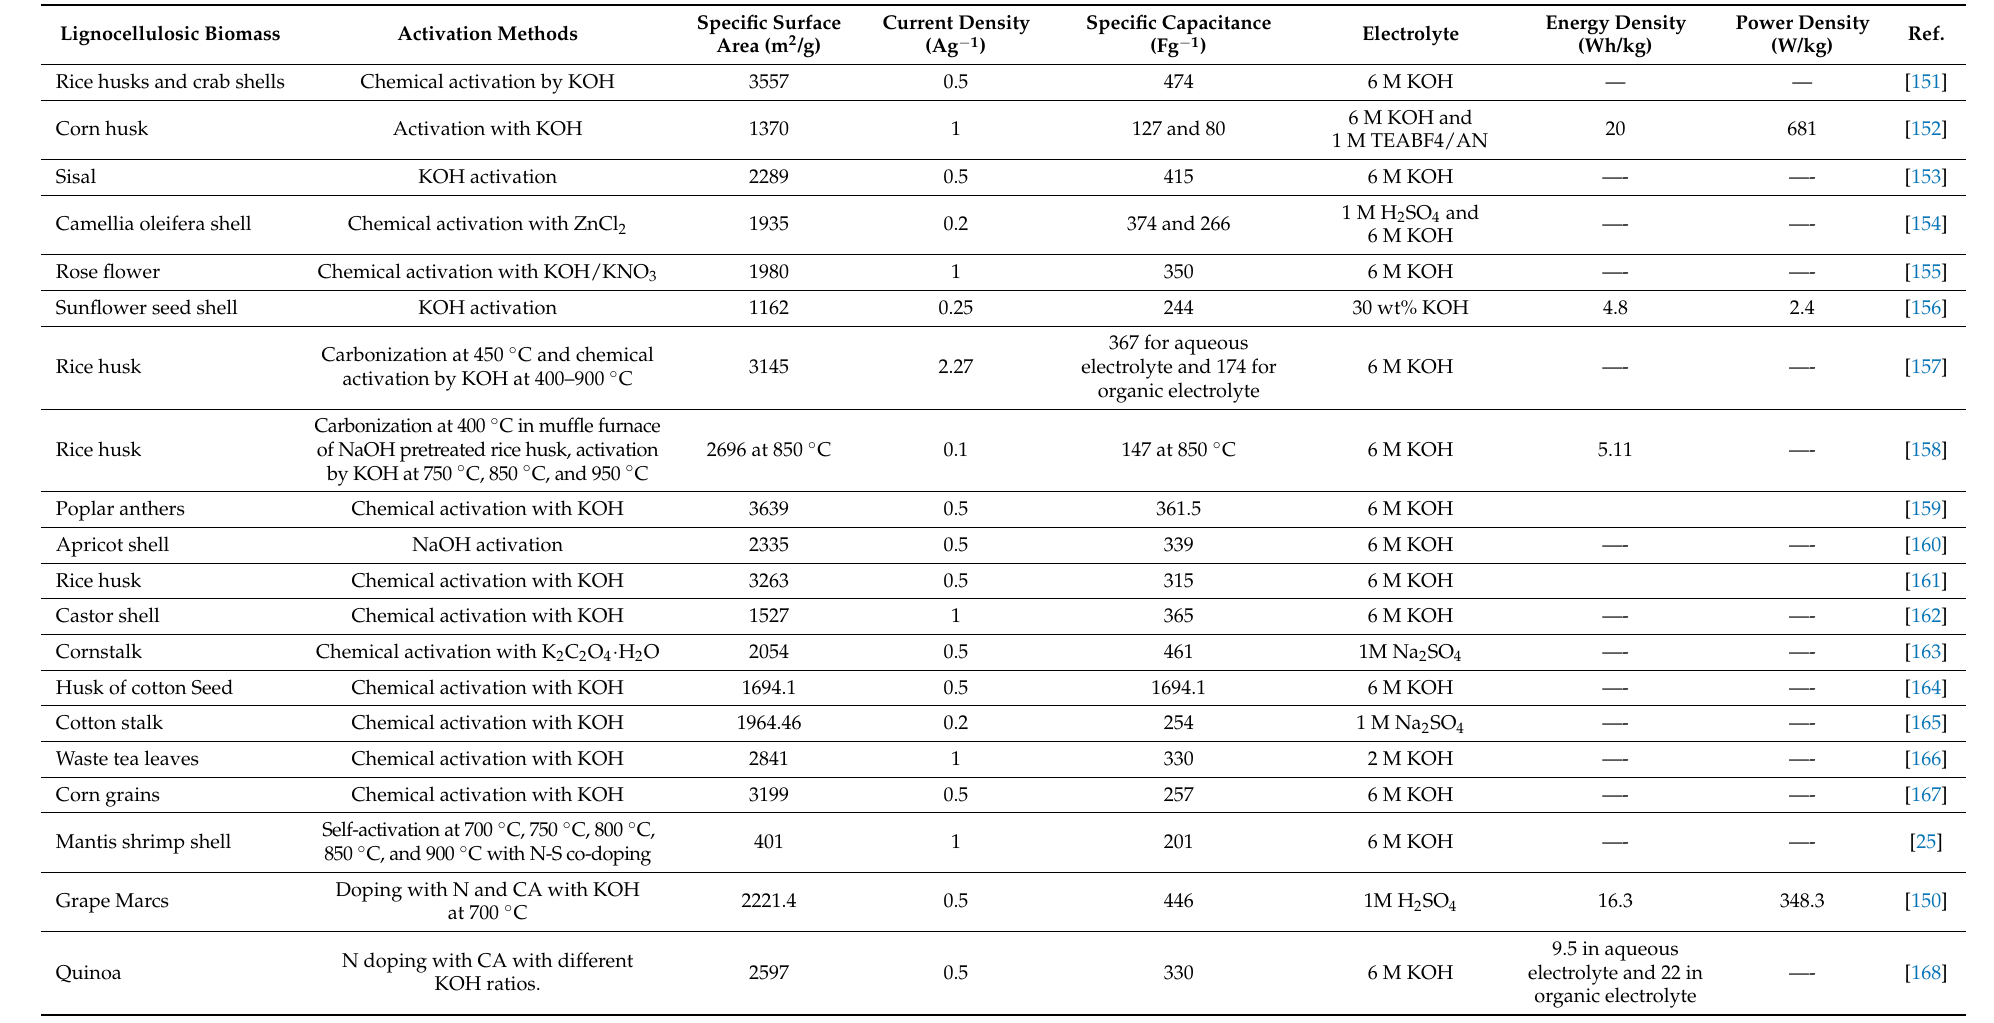
Table 3. Activated carbon production from different biomass feedstocks via activation methods and application for supercapacitor electrodes. Adapted with permission from Ref.